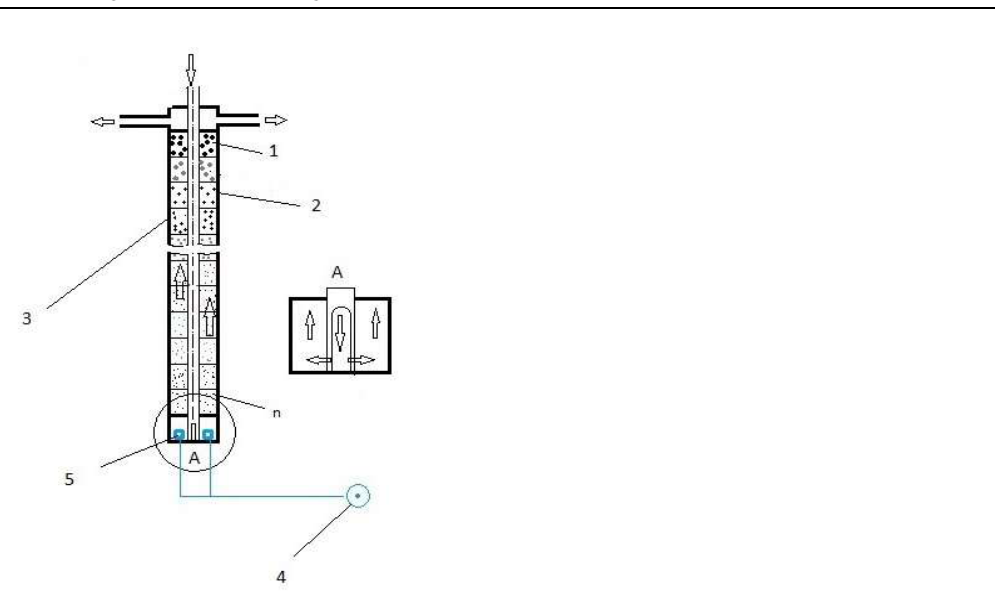
Figure 1. Schematic representation of biological purification of wastewater based on using the zeolite as biomass